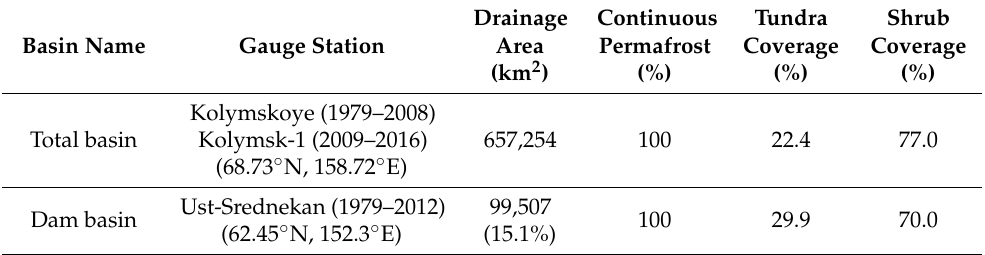
Table 1. Characteristics of the Kolyma River basin together: total basin and sub-basin (Dam